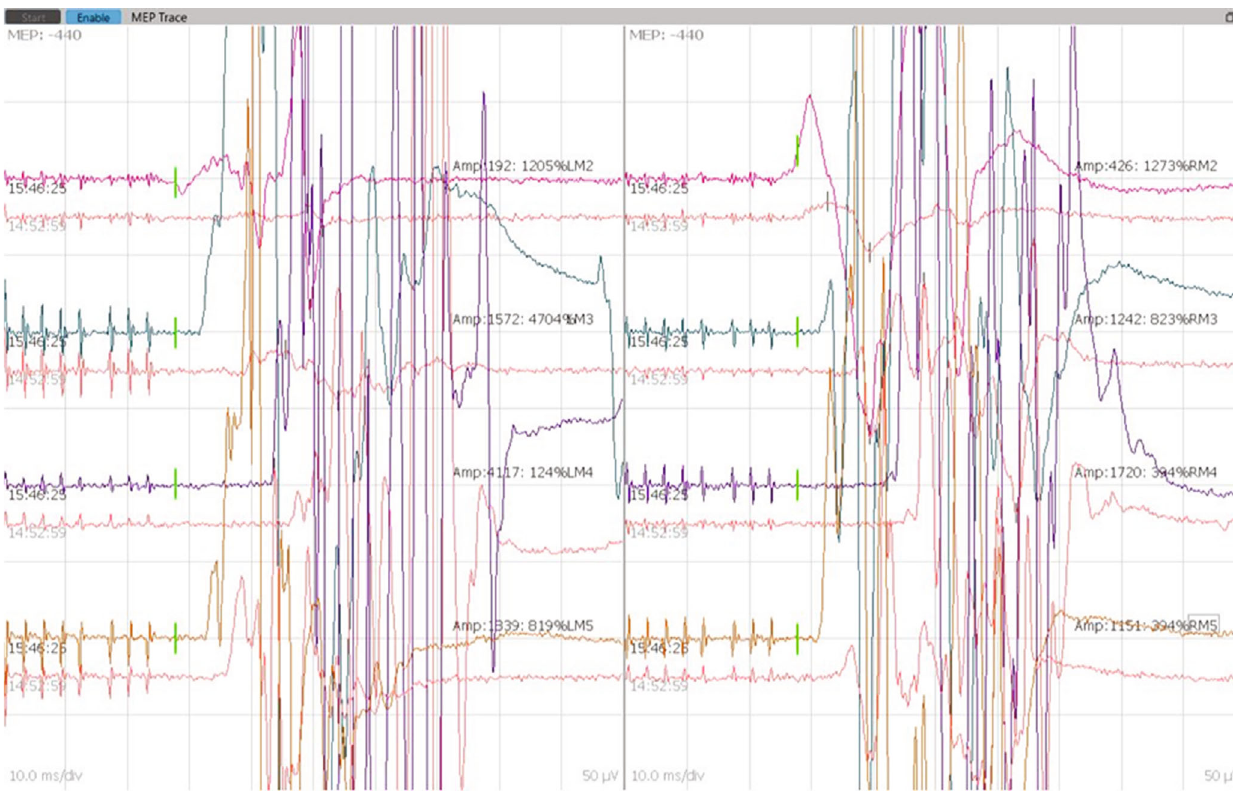
Figure 2: MEP response of a patient from microendoscopic discectomy of the L4/L5 procedure after decompression is performed. LM2 and RM2: bilateral vastus lateralis. LM3 and RM3: bilateral tibialis anterior. LM4 and RM4: bilateral abductor hallucis. LM5 and RM5: bilateral medial